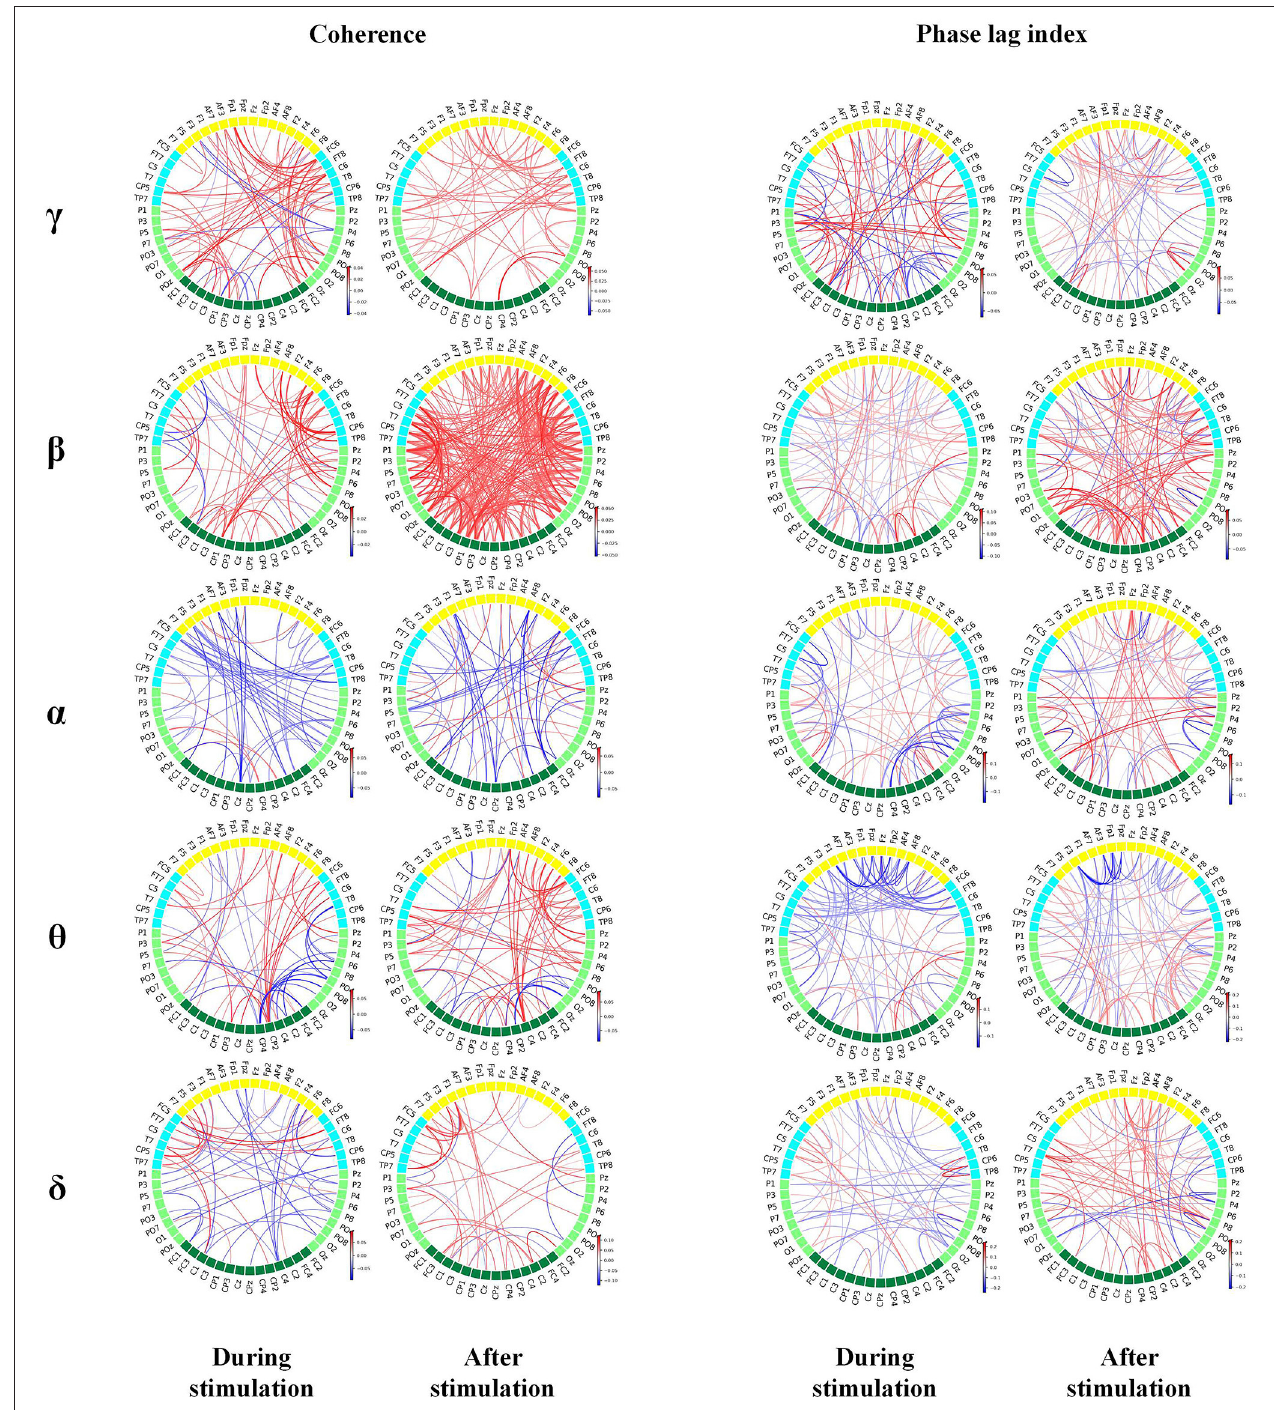
FIGURE 6 | Brain connectivity map based on coherence and phase synchronization. The red line indicates stronger connections, while the blue line indicates weaker connections in awakening patients than in unawakening patients during and after stimulation. The color bar is the connectivity difference. Statistically significant connectivity differences are plotted in the